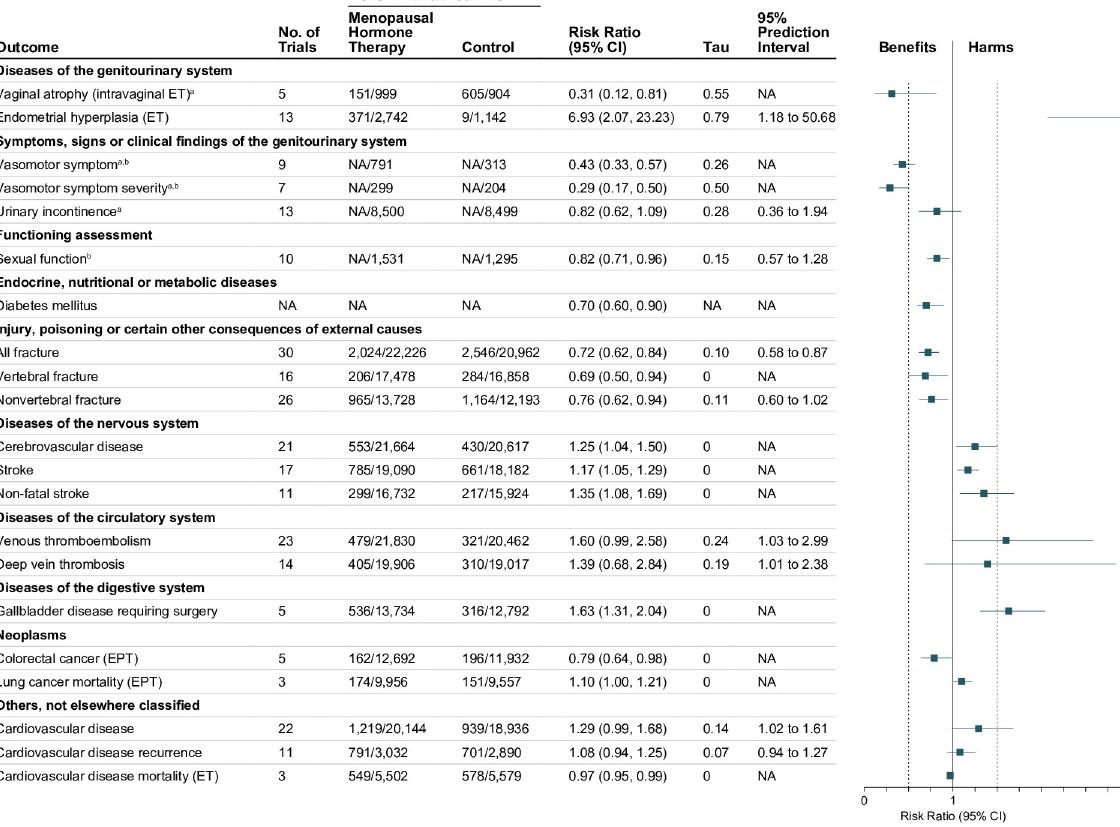
Fig 3. Consistent or highly suggestive evidence from meta-analyses of randomized controlled trials on menopausal hormone therapy and incidence of diseases and other health outcomes. The average effects of any menopausal hormone therapy (ET or EPT) in perimenopausal or postmenopausal women, unless otherwise stated. All estimates are from our own analysis apart from diabetes mellitus. Subgroup analysis results by type of menopausal hormone therapy can be found in Tables F to K in S1 Text. The center of each square represents the summary average effect for each outcome, and the horizontal line represents the corresponding 95% CI. CI, confidence interval; EPT, estrogen plus progestin therapy; ET, estrogen-alone therapy; NA, not available or not applicable. a In women who already have the outcome of interest. b The effect measures for continuous outcomes were converted into the risk ratio scale for comparison; the results in original scale can be found in Tables F and I in S1 Text.